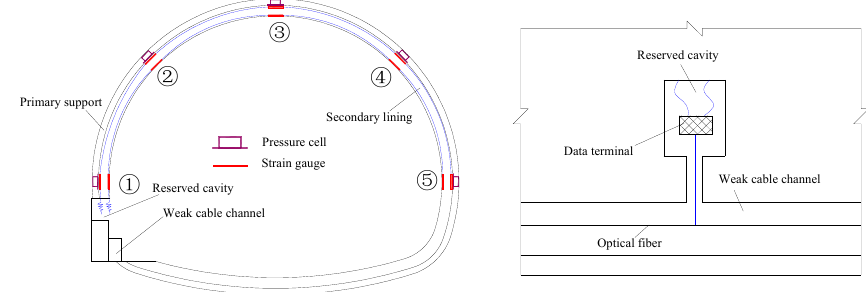
Figure 5. Layout diagram of the long-term monitoring sensors in Cang Ling Tunnel.